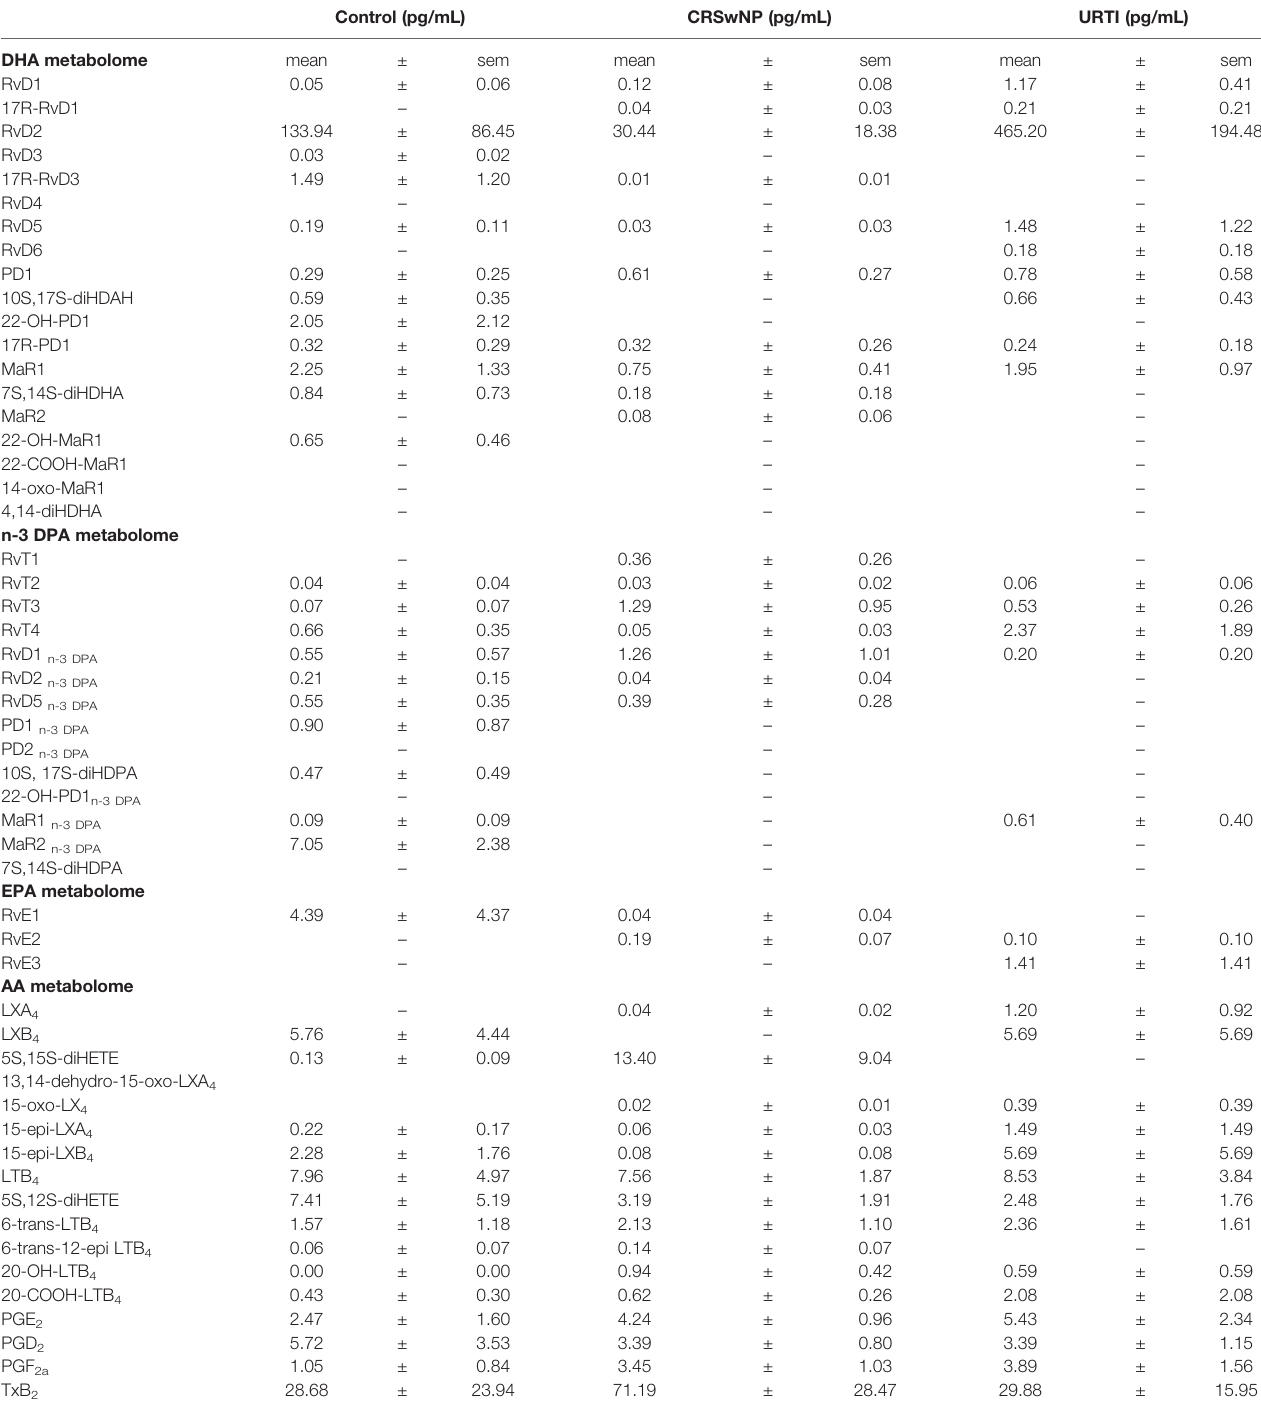
TABLE 2 | Plasma Lipid mediator